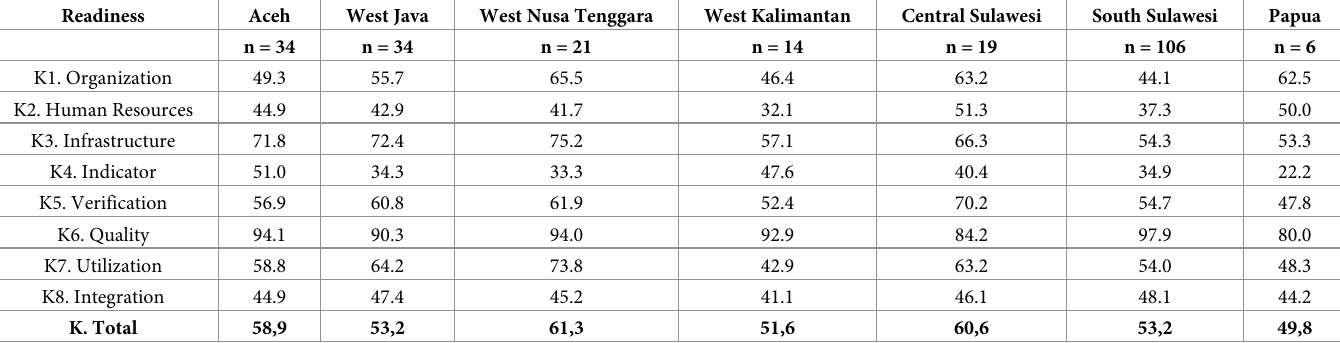
Table 3. Readiness of malaria surveillance information systems at primary health centers by province (n = 234).